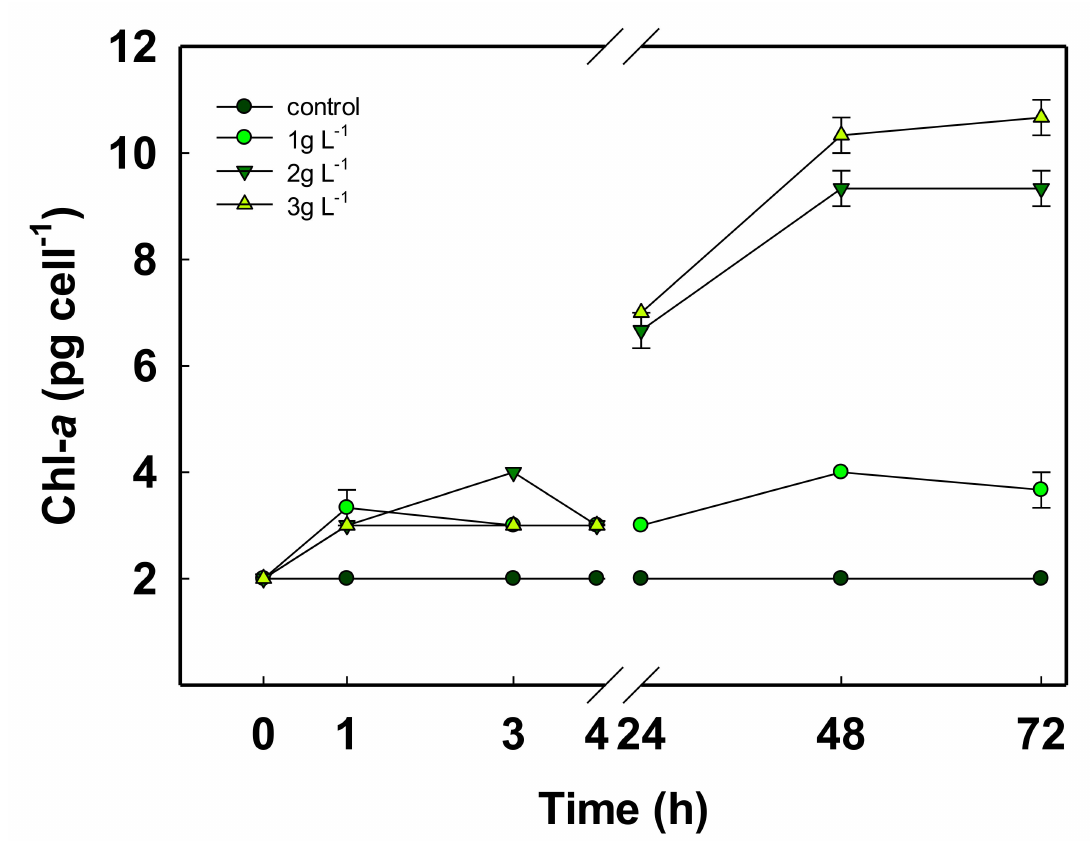
Figure 4. Chlorophyll a content in Chlorella sorokiniana control and in bicarbonate enriched cultures